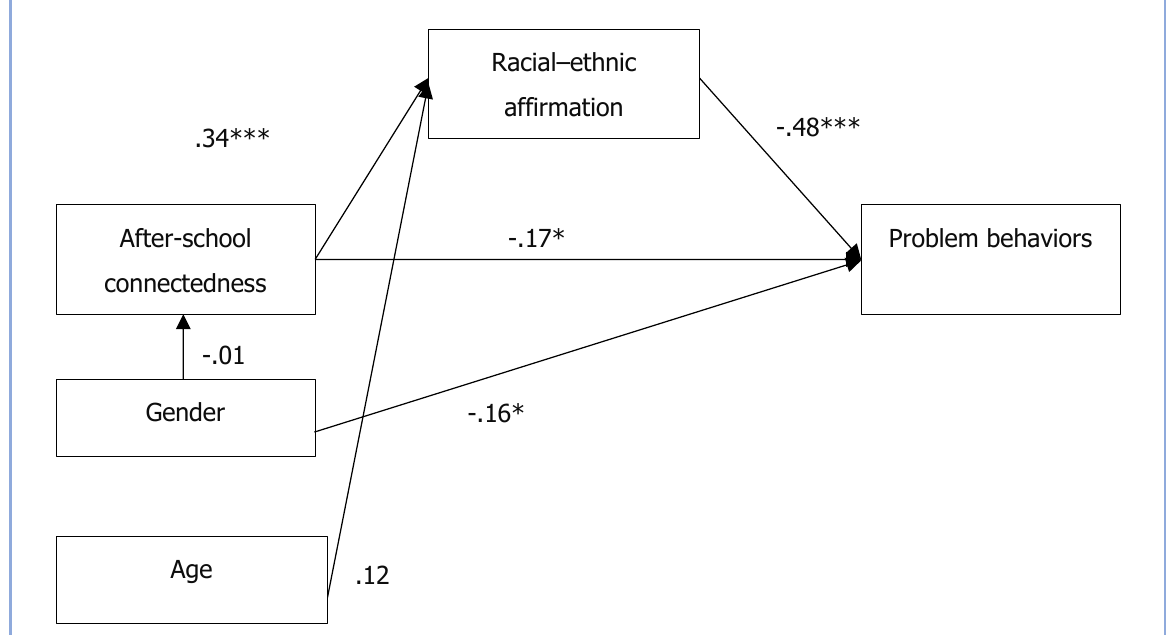
Figure 2. Full Mediation